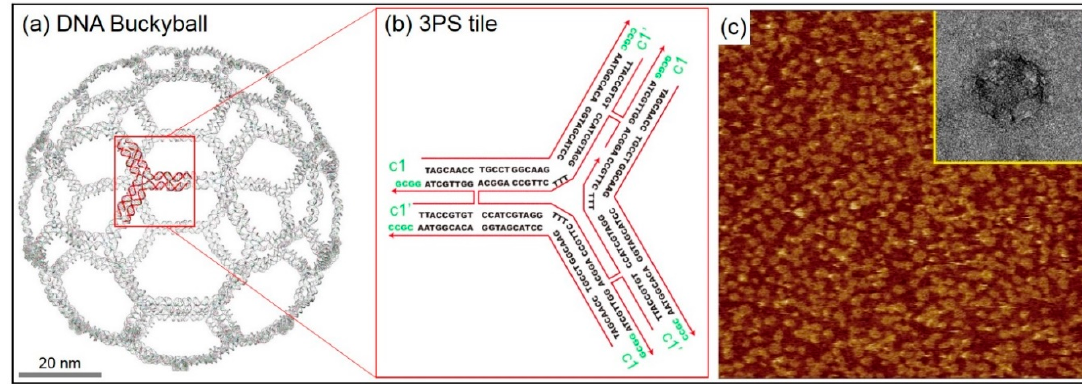
Figure 2. Finite-size DNA 3D buckyball structure with its unit tile sequence, representative atomic force microscope (AFM) and transmission electron microscope (TEM) images. ( a ) Schematic diagram of a DNA 3D buckyball structure composed of three-point-star (3PS) unit tiles. ( b ) DNA base sequence of a 3PS unit tile. The complementary sticky end pairs are shown as c1 and c1’. ( c ) AFM and TEM images of the DNA 3D buckyball structure. Scan sizes of the AFM and the TEM images in the inset are 3 × 3 μ m 2 and 100 × 100 nm 2 , respectively.